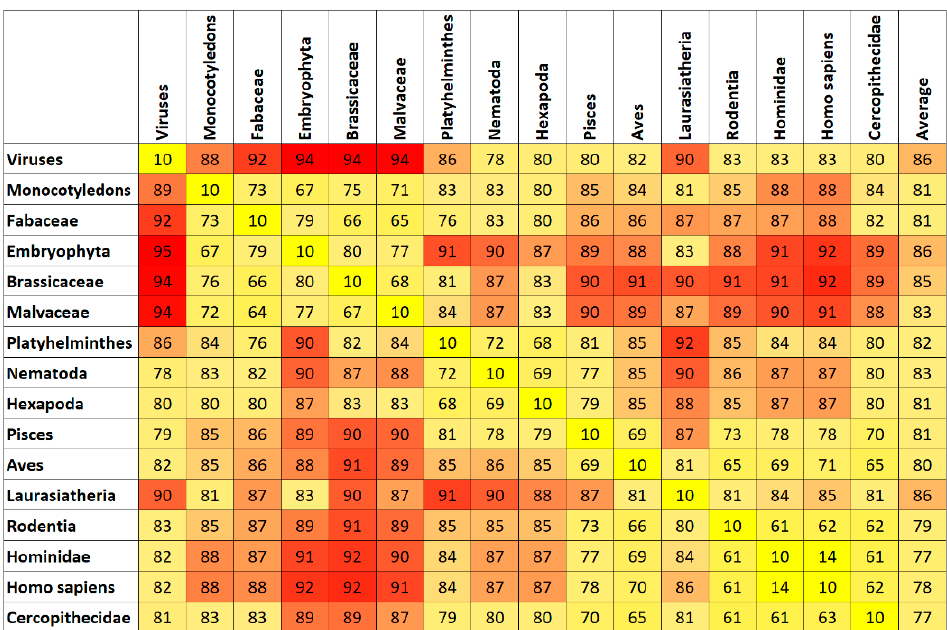
Figure 5. Results in the figure stem from k-mer first–last distance features only. Average accuracy for 100-fold MCCV using a random forest classifier and a split of 80% training and 20% testing. Yellow shades refer to lower accuracy, while red shades indicate higher average classification accuracy.